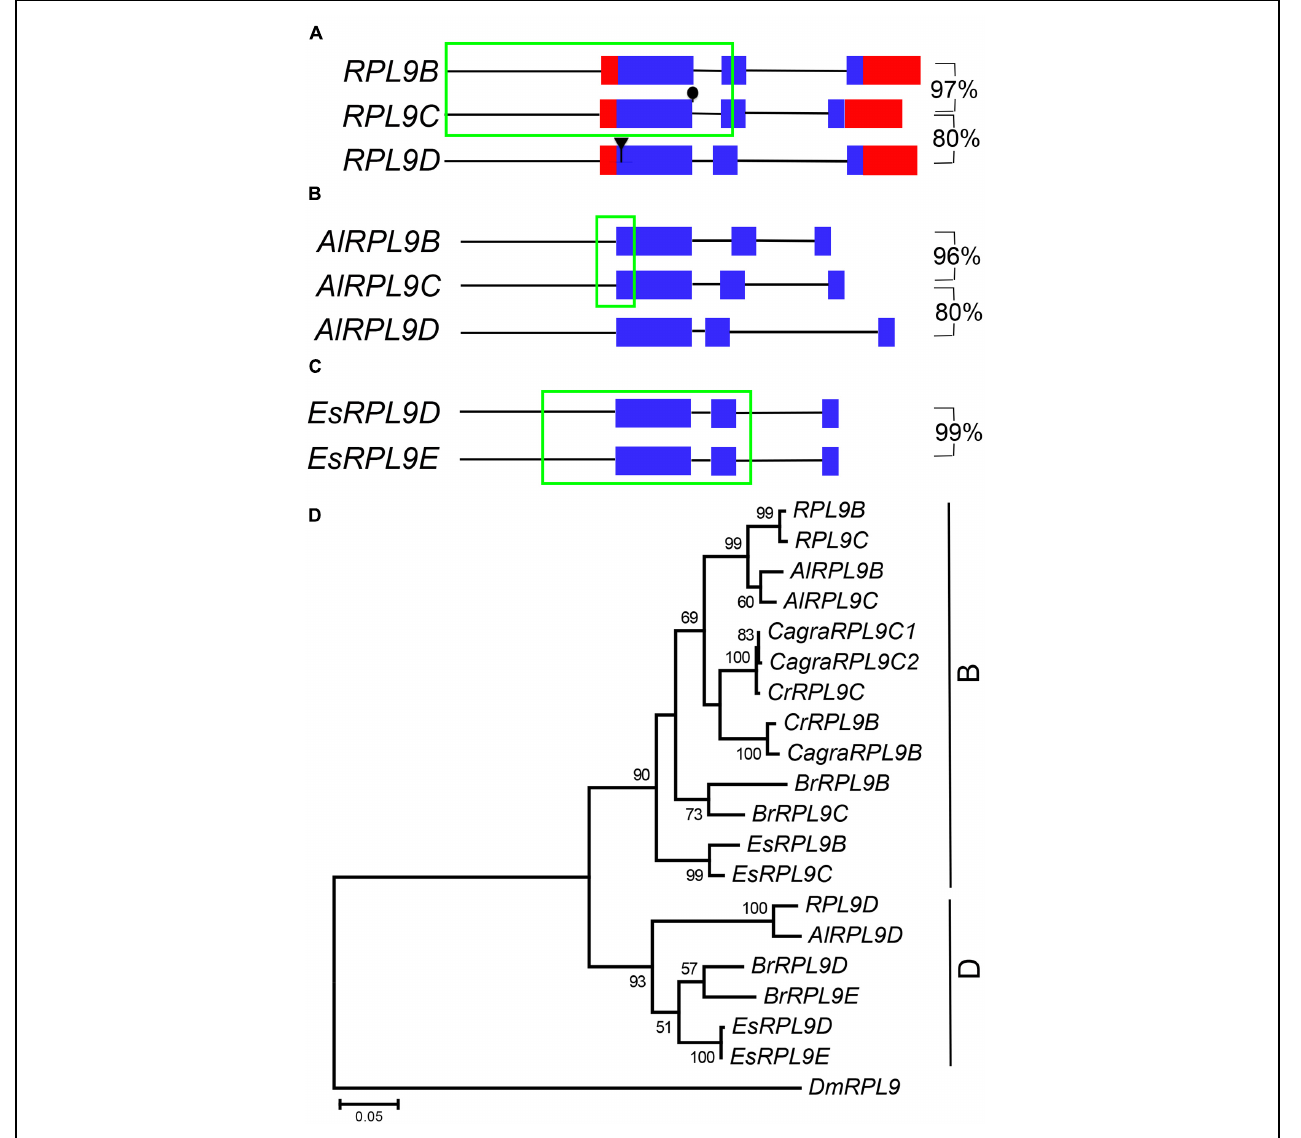
FIGURE 3 | RPL9 genes in Brassicaceae. Diagrammatic representation of A. thaliana (A) , Arabidopsis lyrata (B) , and Eutrema salsugineum (C) genes showing UTR’s (red), exons (blue), non-coding upstream, and intron sequences (black line), and regions of 100% nucleotide sequence identity (green). Percentage nucleotide sequence identity of exons (excluding region in green box) is shown for gene pairs. Phylogenetic tree shown in (D) includes A. thaliana , A. lyrata ( AlRPL9 ), Capsella rubella ( CrRPL9 ), C. grandiflora ( CagraRPL9 ), E. salsuginum ( EsRPL9 ), B. rapa ( BrRPL9 ), and Drosophila melanogaster ( DmRPL9 )